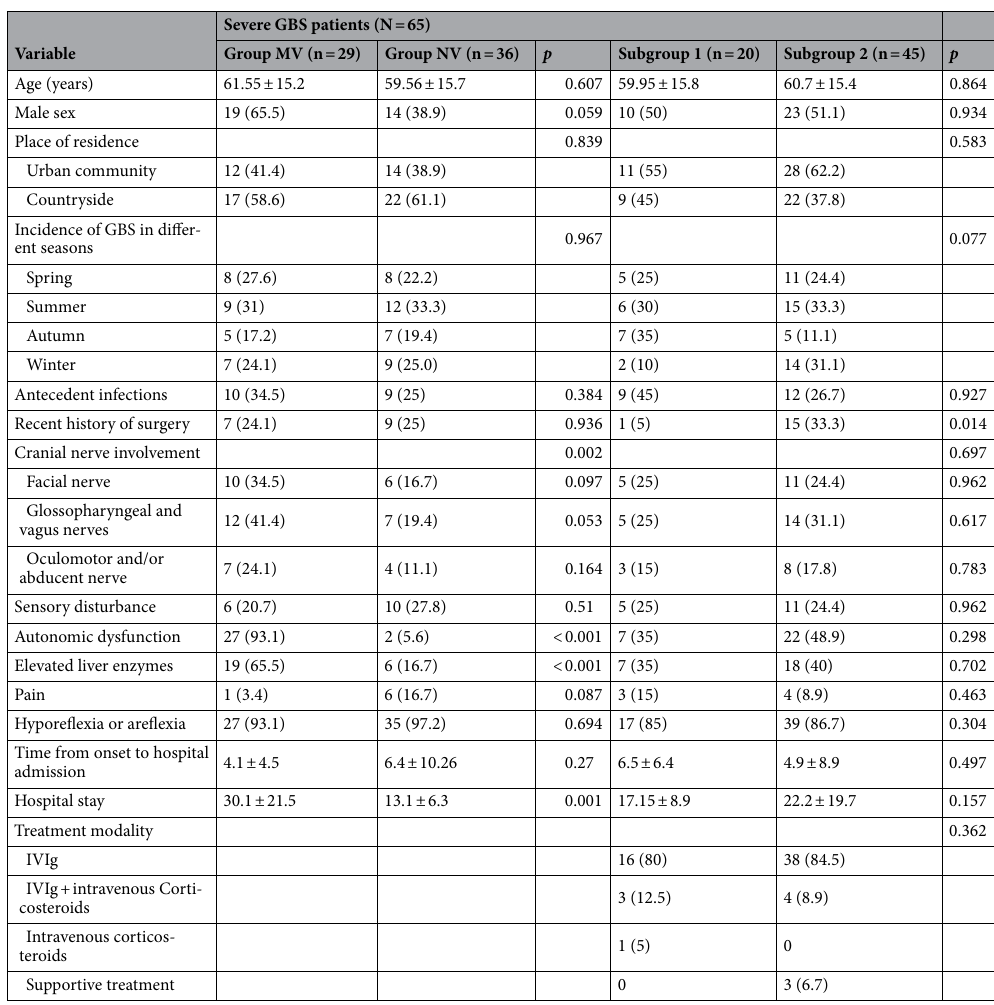
Table 4. Comparison of clinical characteristics and presentation of GBS between Groups MV and NV and between Subgroups 1 and 2. GBS: Guillain-Barré syndrome; MV: Mechanical ventilation; IVIg: Intravenous